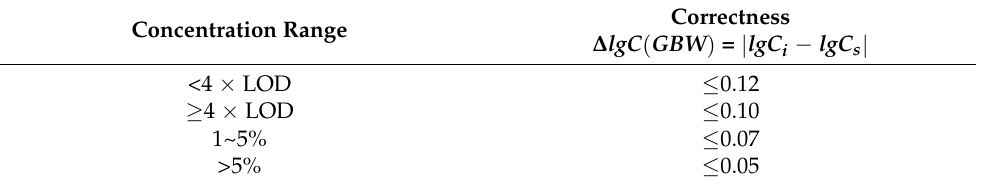
Note: Ci is the single measurement value and Cs is the standard value for the GBW standard sample. Table A6. Permissible relative deviations for parallel double